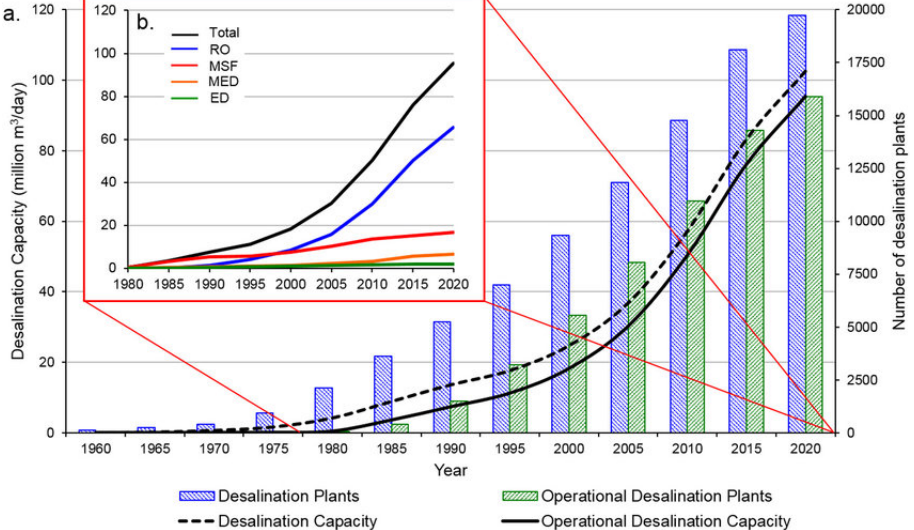
Figure 1. ( a ) Global installed desalination capacity 1960–2020, ( b ) operational capacity by desalination technology. Reproduced with permission from E. Jones et al., Science of the Total Environment); published by ScienceDirect, 2019 [5].